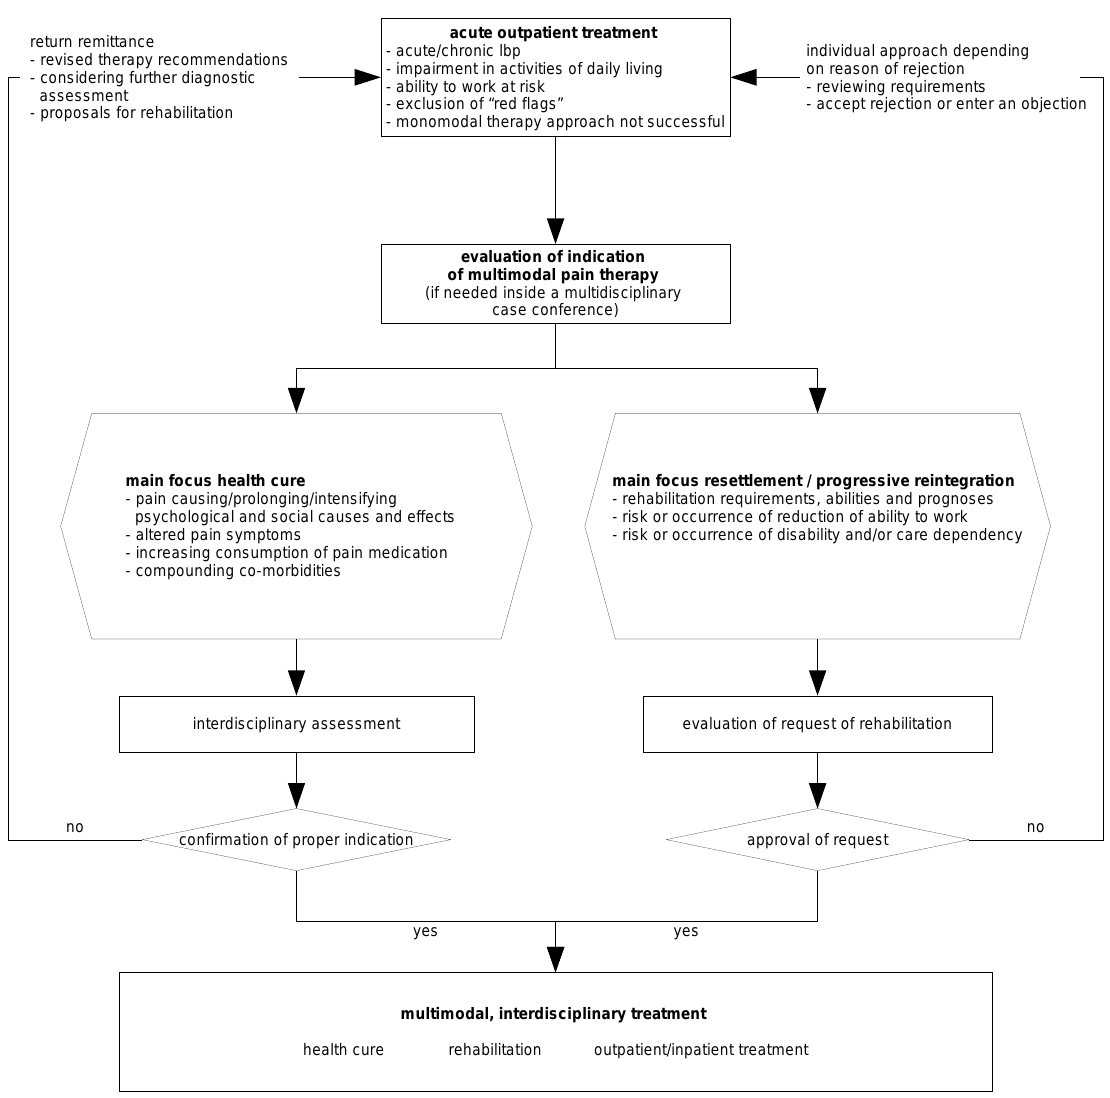
Figure 1. Algorithm for treatment of patients with unspecific LBP according to the suggestions of the National Disease Management Guidelines (NVL).